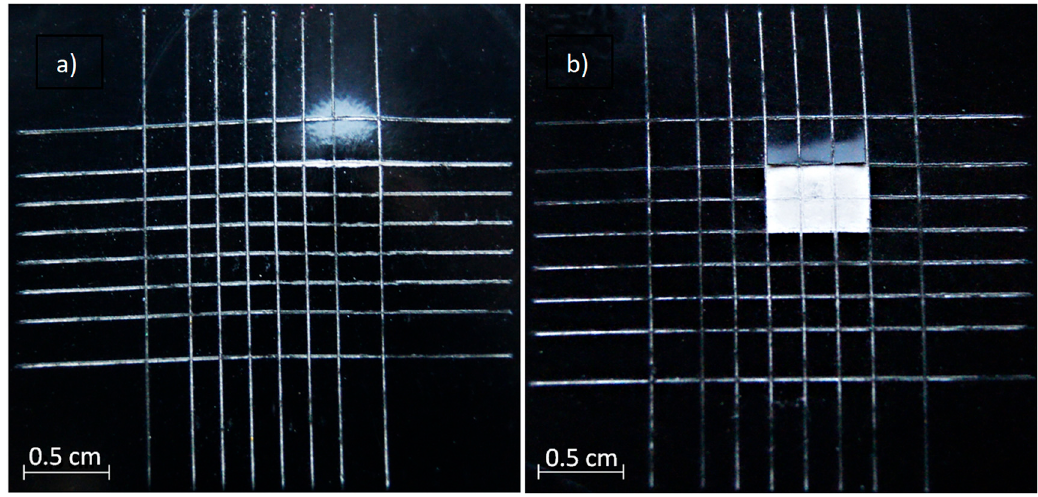
Figure 20. Surface appearance of ( a ) Ti/Zr + polymer and ( b ) PEO + polymer coatings after impact + adhesion tests [63]. Reprinted from [63] with permission from Elsevier.